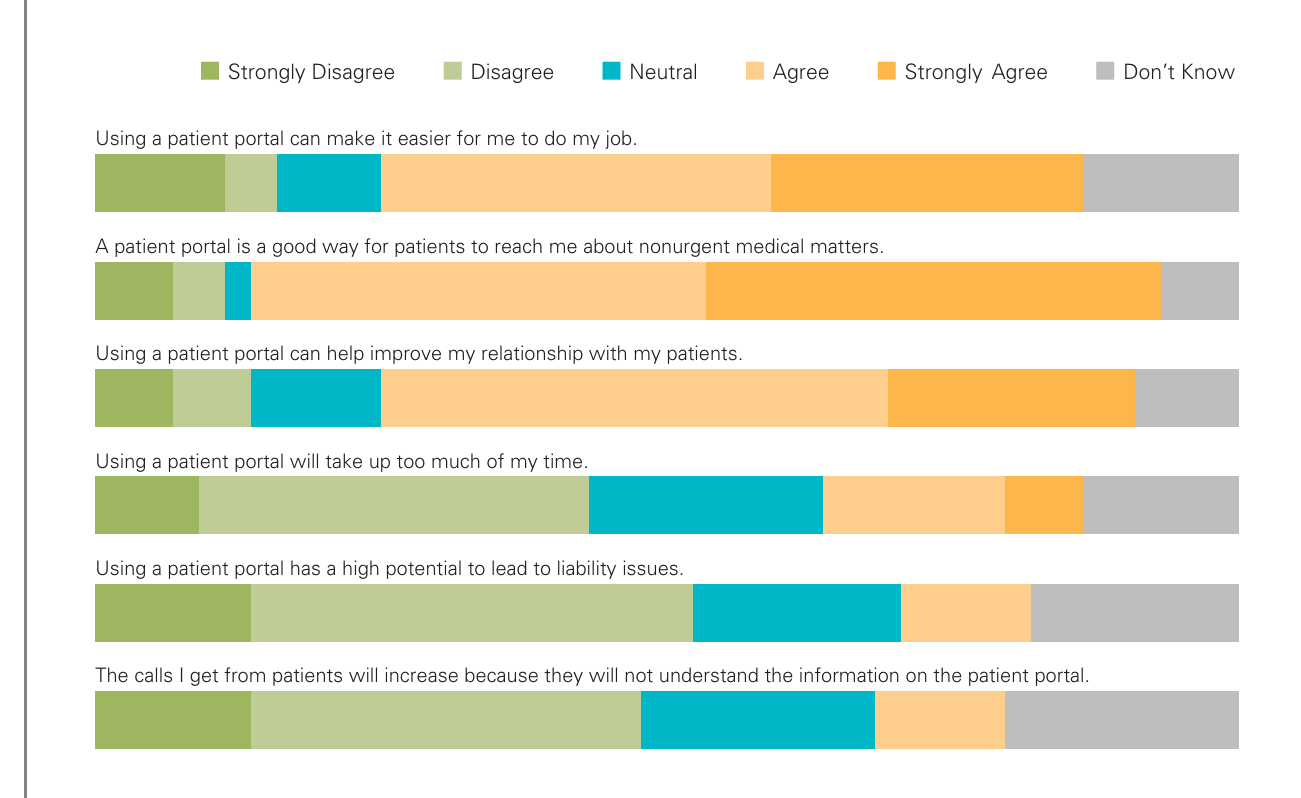
Figure 2. Clinician and Staff Opinions about Patient